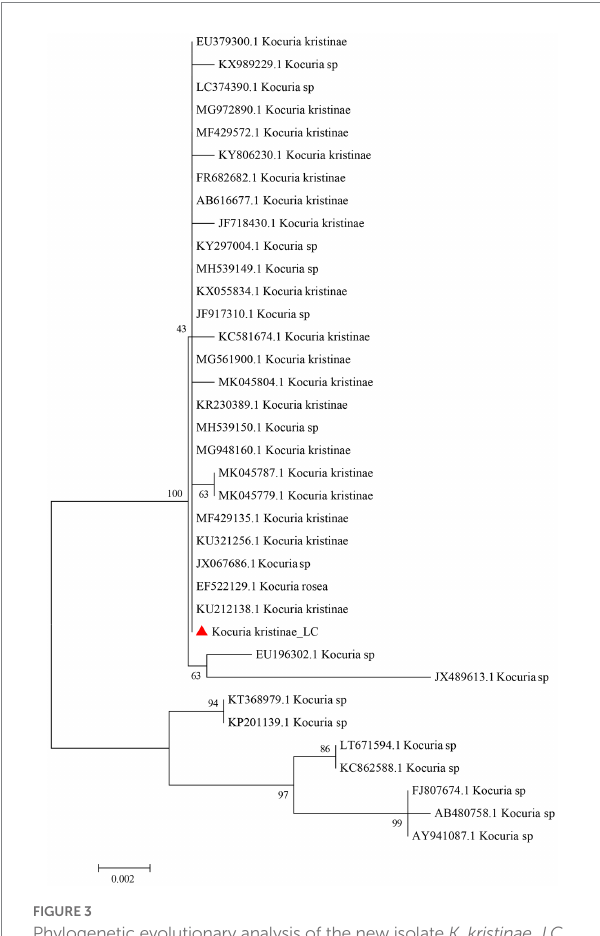
FIGURE 3 Phylogenetic evolutionary analysis of the new isolate K. kristinae_LC with other species. A phylogenetic tree was constructed based on the 16S rRNA sequence by the N-J tree method in the MEGA 6.0 software package using 2,000 bootstrap replicas.